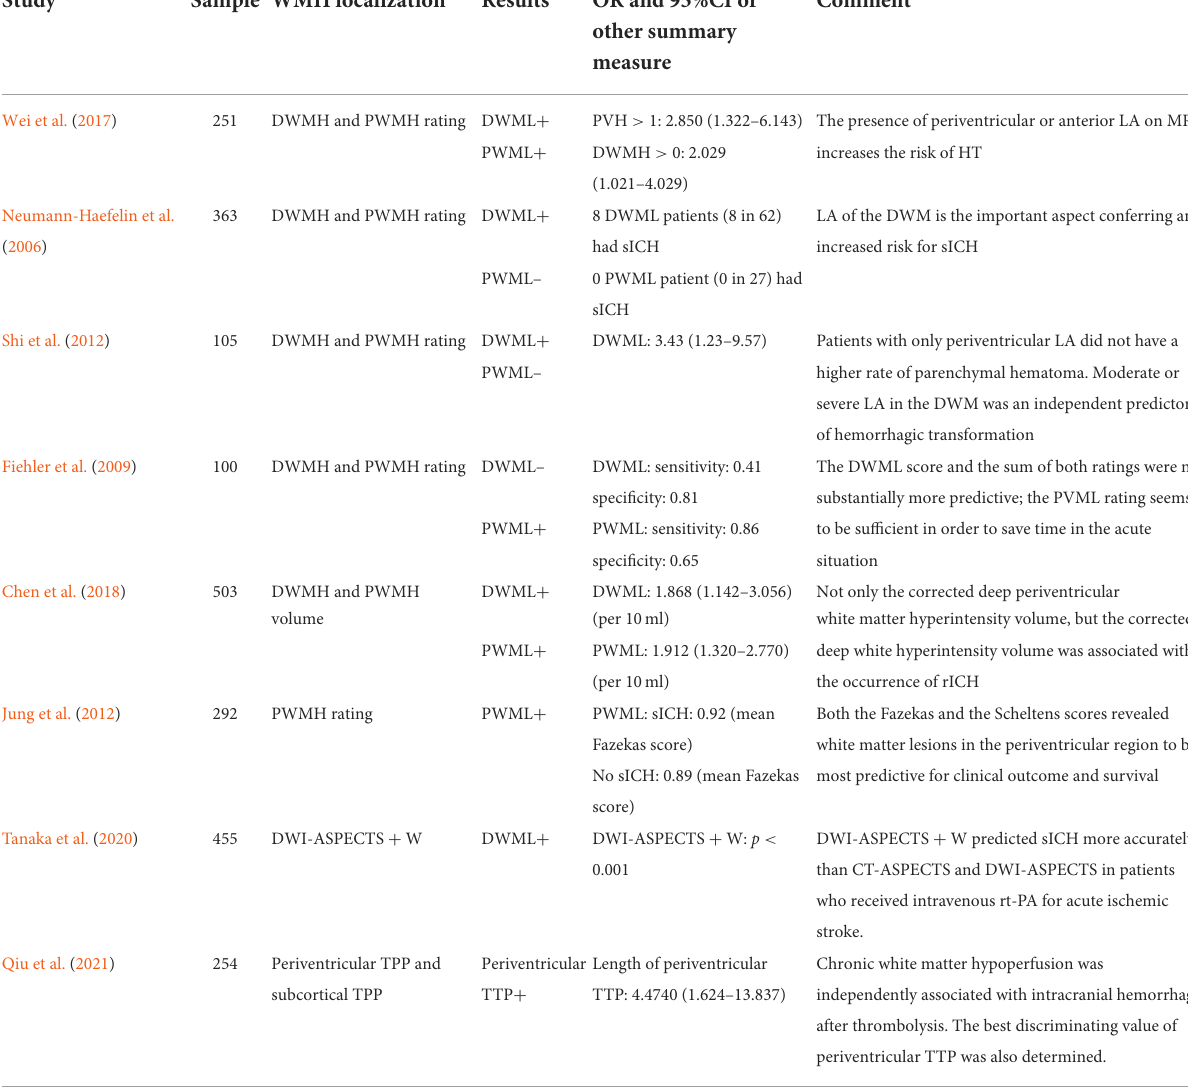
TABLE 1 Relation between the distribution of white matter lesion (WML) and hemorrhagic transformation